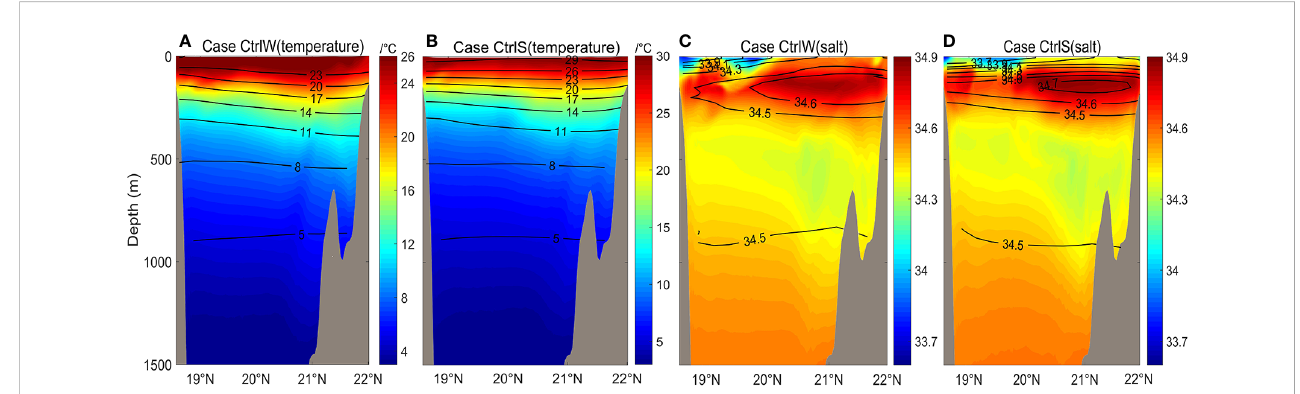
FIGURE 3 Simulated temperature and salinity pro fi les at 120.75°E, 18.5°N-22°N (blue line section in Figure 1) overlaid with WOA18 (world ocean database) annual mean data within the upper 1500 m. (A) Simulated temperature pro fi le of winter case in color, with WOA18 temperatures as black contours. (B) Same as (A) except summer. (C) Same as (A) except salinity pro fi le in winter. (D) Same as (C) except